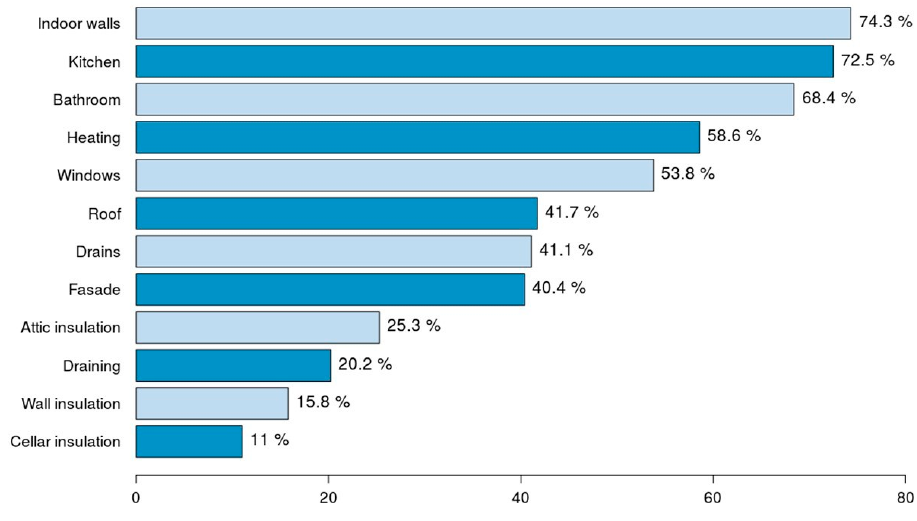
Figure 4. Frequency of renovation work by type.